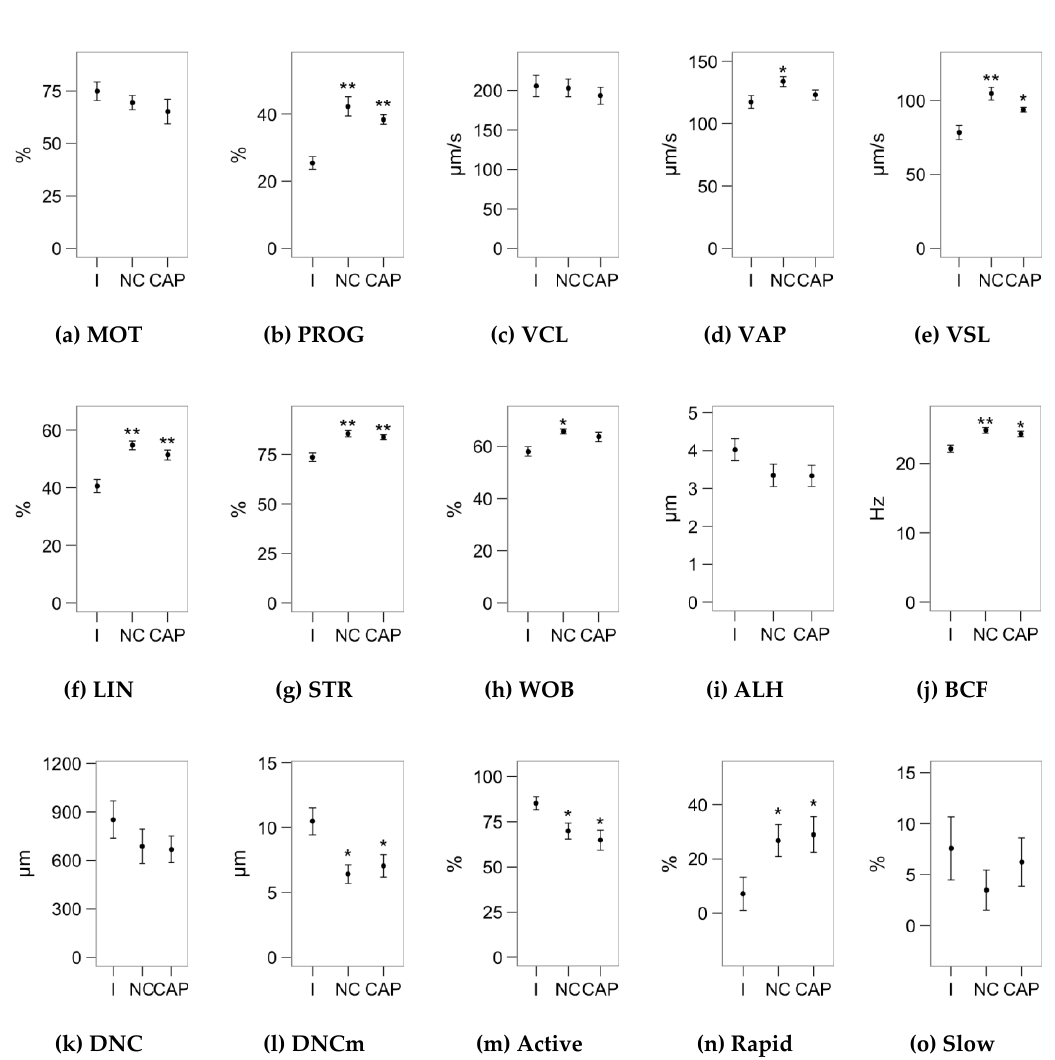
Figure 1. Results of sperm analyses (motility by computer-assisted sperm analysis (CASA) and motility subpopulations) in the unprocessed samples (initial assessment, I) and after the incubation (4 h at 37 ◦ C and 5% CO 2 ) in non-capacitating (NCAP) and capacitating (CAP, 2 UI / mL heparin) conditions. Plots show mean s± SEM for each variable and sampling point. ( a ) Total motility. ( b ) Progressive motility. ( c ) Curvilinear velocity. ( d ) Average-path velocity. ( e ) Straight-path velocity. ( f ) Linearity. ( g ) Straightness. ( h ) Wobble. ( i ) Amplitude of the lateral displacement of the sperm head. ( j ) Frequency of the flagellar beat. ( k ) Dance. ( l ) Dance mean. ( m ) “Active” spermatozoa, highest velocity and dance. ( n ) “Rapid” spermatozoa, high velocity and low dance. ( o ) “Slow” spermatozoa, lowest velocity and linearity. Asterisks indicate significant differences of the incubated samples with the initial assessment (* p < 0.05, ** p < 0.01).